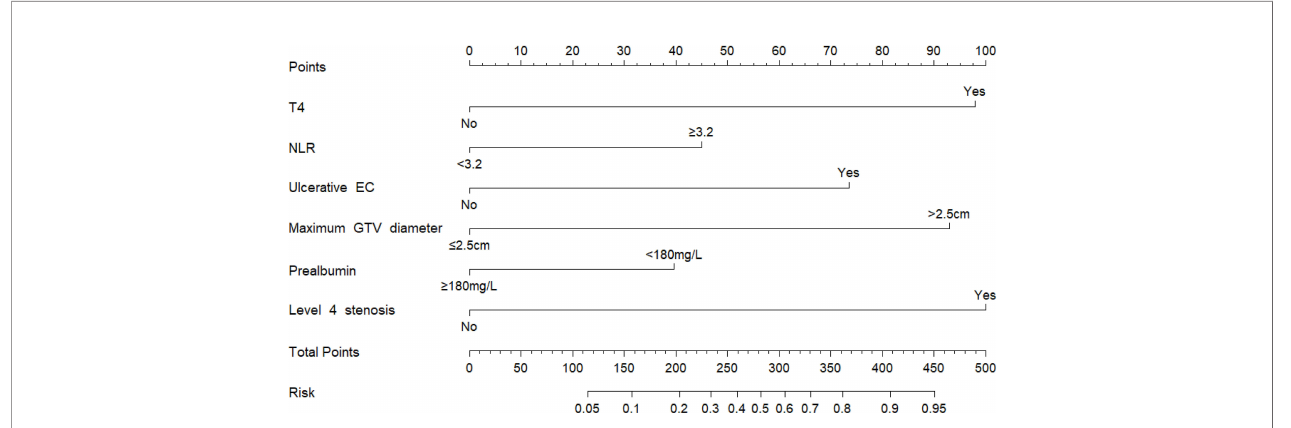
FIGURE 2 | Nomogram for the individualized prediction of radiation-related esophageal fi stula in esophageal cancer patients. The nomogram was developed in the cohort, using T4, level 4 stenosis, ulcerative EC, prealbumin, and maximum diameters of GTV and NLR. GTV, gross tumor volume; NLR, neutrophil-to-lymphocyte